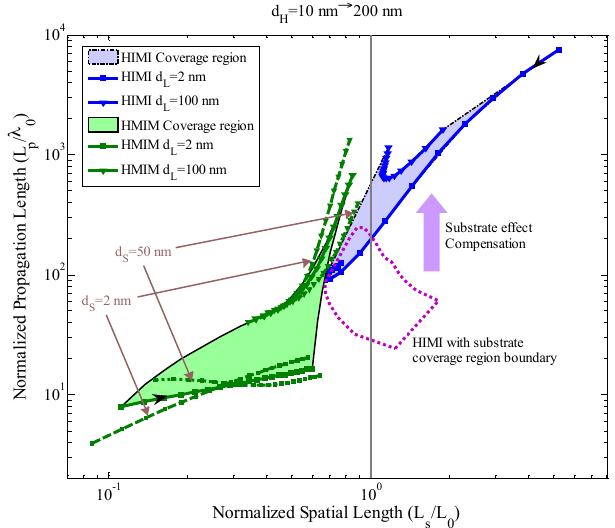
Figure 14: Comparing the HIMI and HMIM slab waveguides using the normalized propagation length (L p / λ 0 ) vs. normalized spatial length (L s /L 0 ) plot, with: d M = 20 nm, d S =2, 20, 50 nm, d L =2–100 nm, and d H =10–200 nm. Shaded areas are for d M = d S =20